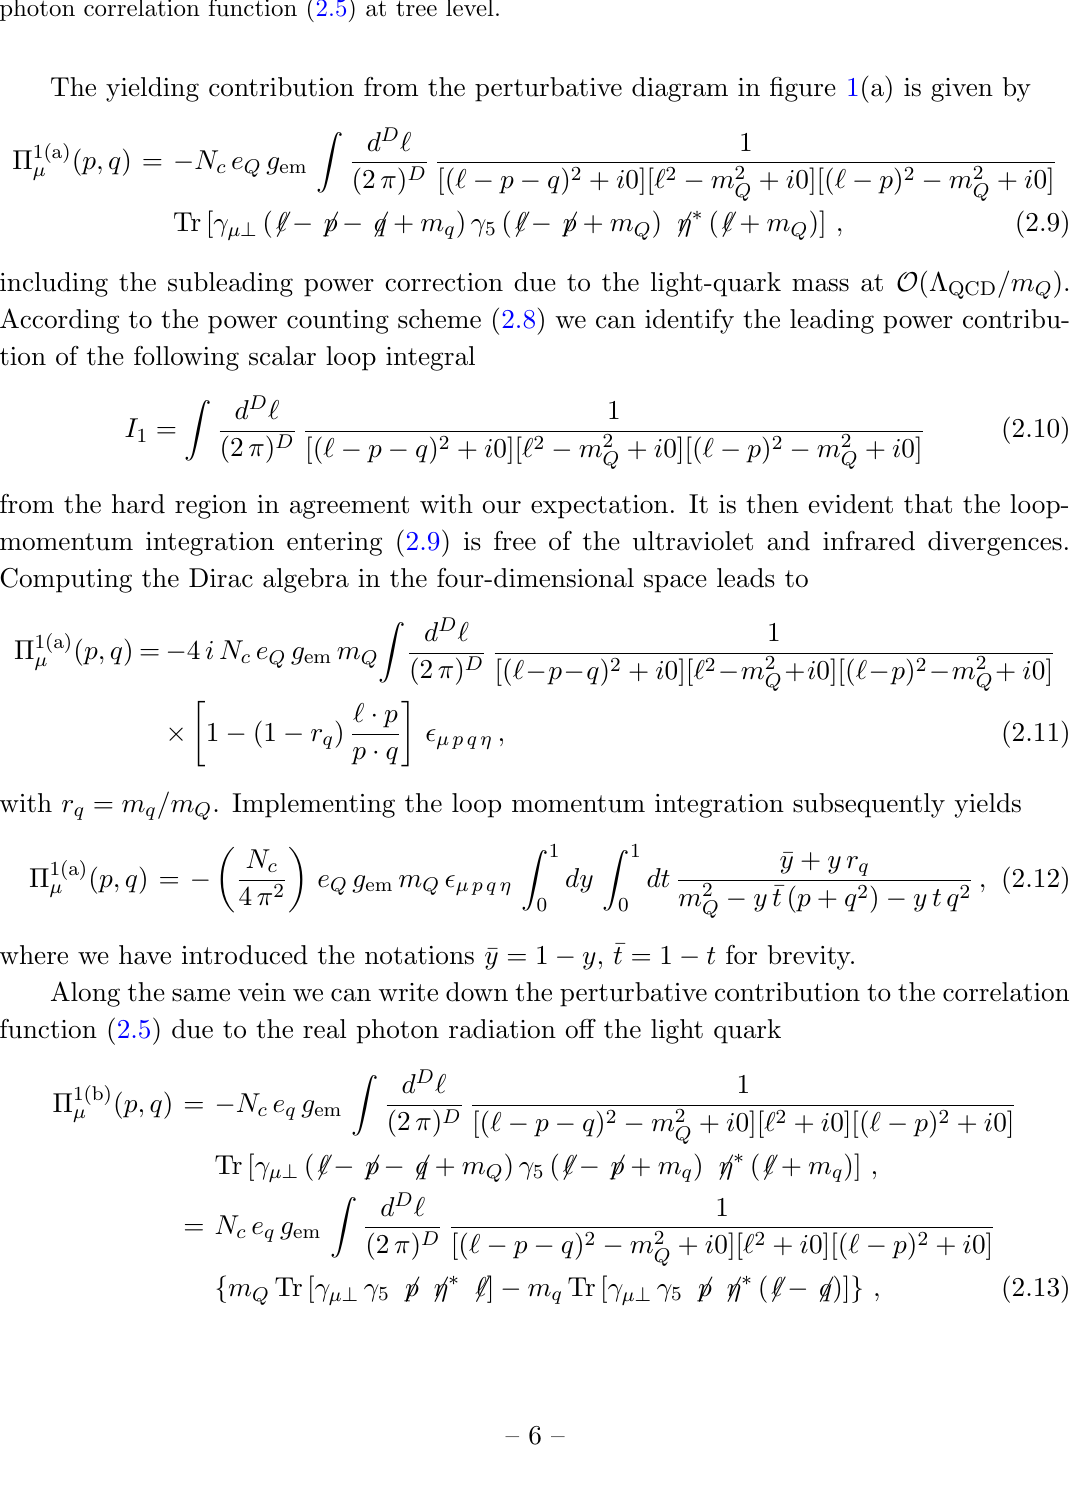
Figure 1 . Diagrammatic representation of the \point-like" photon contribution to the vacuum-to- photon correlation function (2.5) at tree